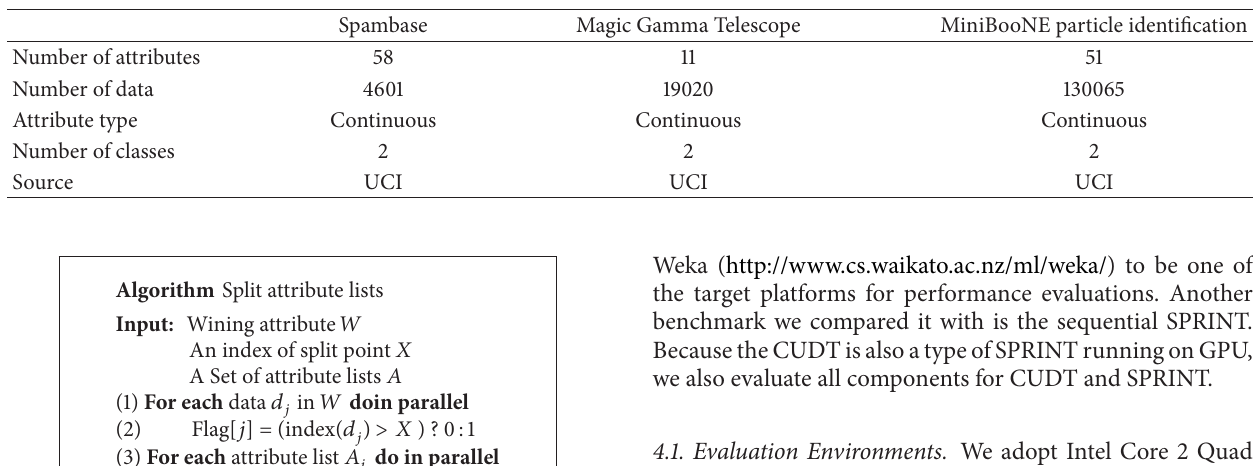
Table 1: Test data set.